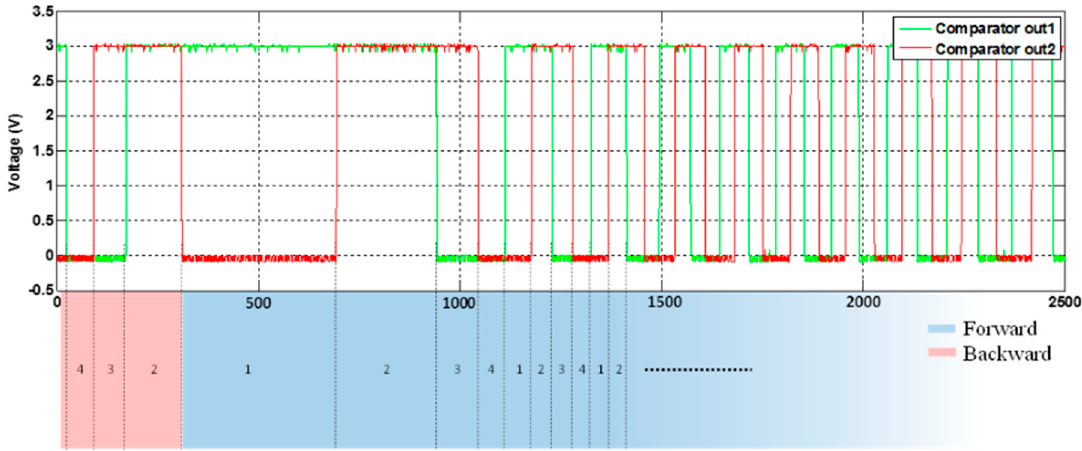
Figure 14. The result of comparator output to determine the direction of the MR sensor.